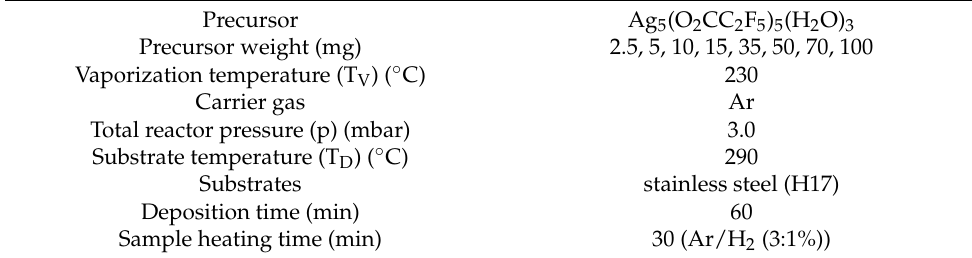
Table 1. Deposition parameters of AgNPs’